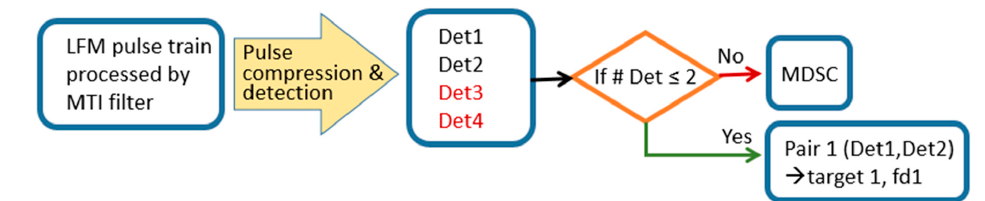
Figure 25. Clutter-suppression, multi-Doppler-shift-compensation (CS-MDSC) workflow.